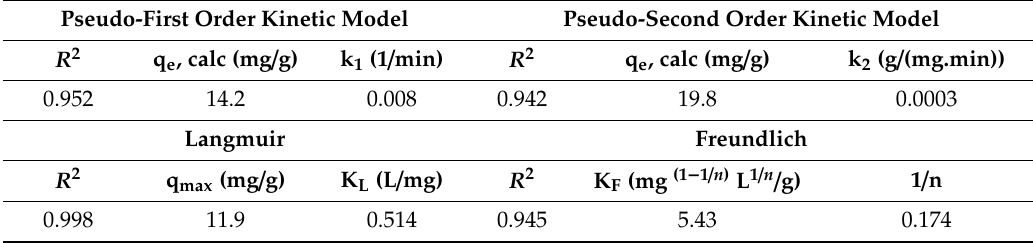
Figure 4. N 2 adsorption–desorption isotherm at 77 K of the char sample and textural parameters calculated from the isotherm. Table 3. Parameters obtained from kinetic modelling and from Langmuir and Freundlich modelling for RY adsorption on ST-derived